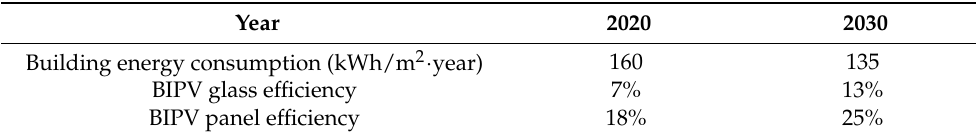
Table 3. The different scenario